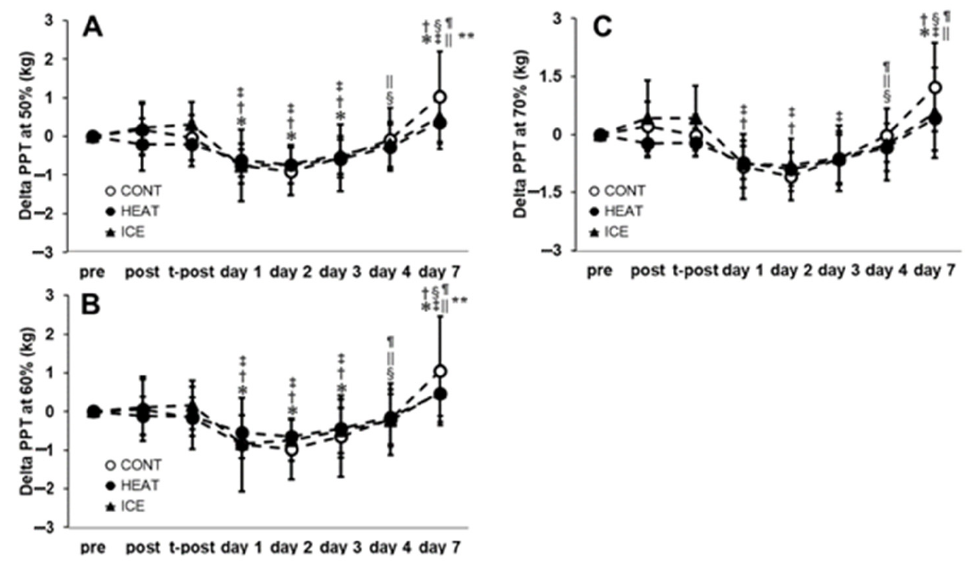
Figure 5. Changes in pain pressure thresholds at 50% ( A ), 60% ( B ), and 70% ( C ) of the upper arm. * significant compared with pre ( p < 0.05); †, significant compared with post; ‡, significant compared with t-post; §, significant compared with day 1; ||, significant compared with day 2; ¶, significant compared with day 3; **, significant compared with day 4.